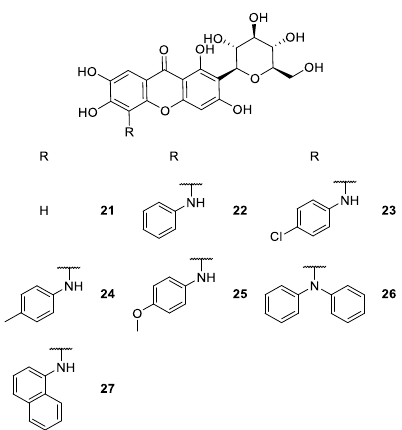
Figure 4. Structures of mangiferin ( 21 ) and some synthetic derivatives 22 – 27 with antipyretic and antimicrobial activities.